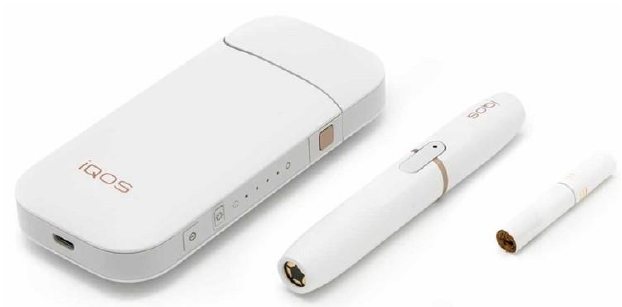
Figure 2. Picture and description of IQOS provided to respondents.